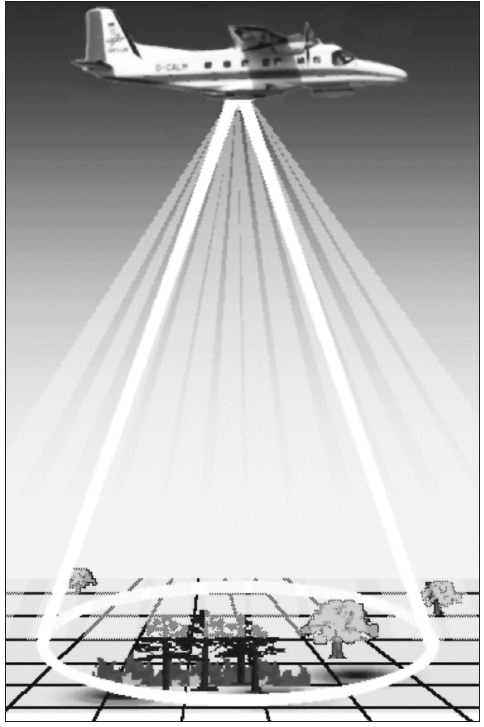
Fig. 5. Footprints of MIROR and ABAS. ABAS de- termines the distribution of the surface radiance within the MIROR